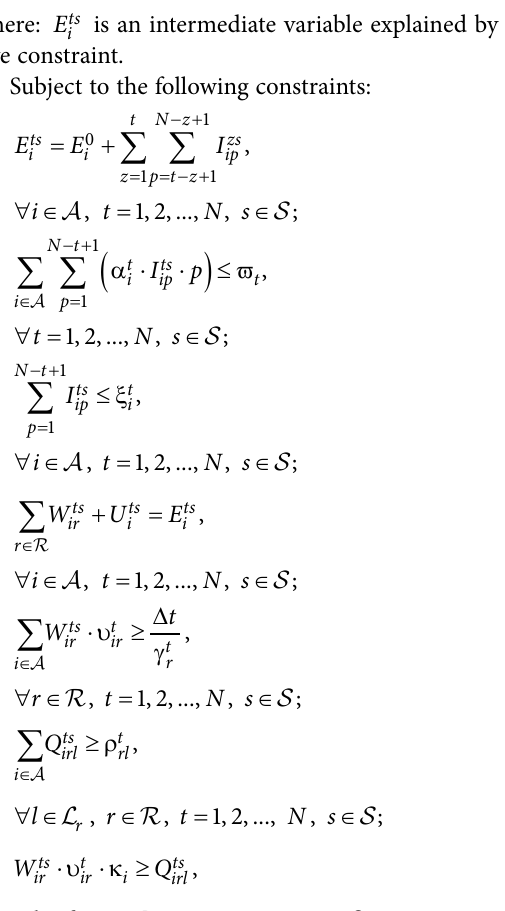
Figure 1. Decision steps with non-anticipativity